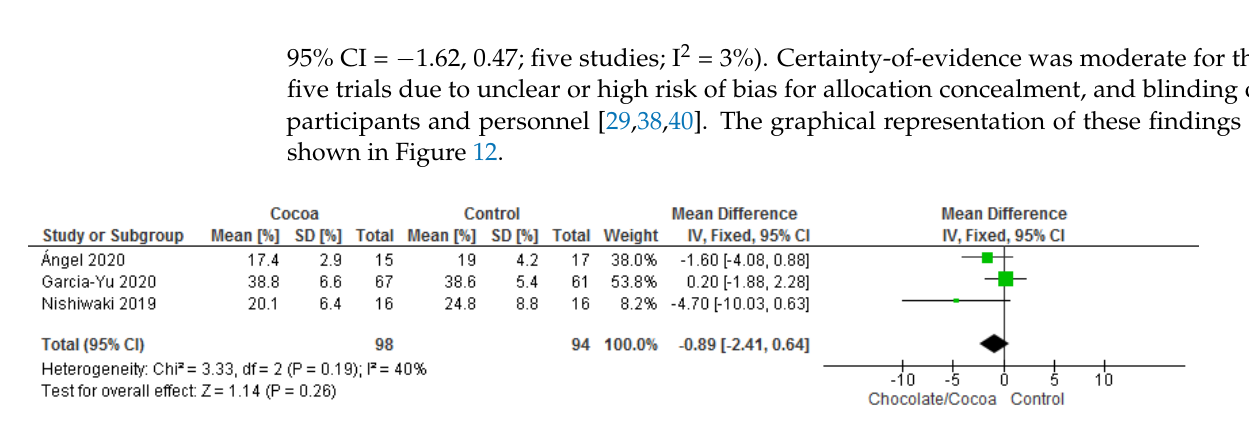
Figure 12. Forest plot of comparison: chocolate versus control, with the outcome - body fat percentage (%).